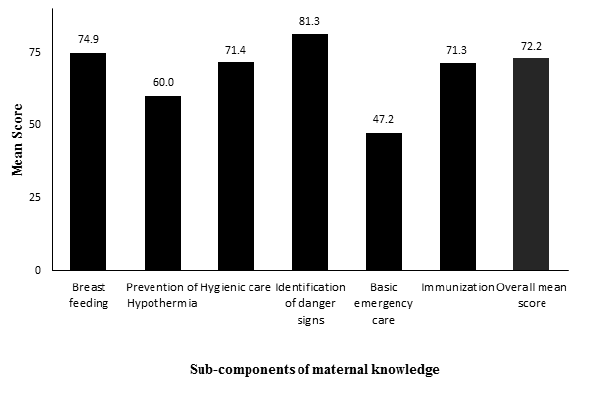
Figure 1. Median scores of the sub-components of maternal knowledge on newborn care